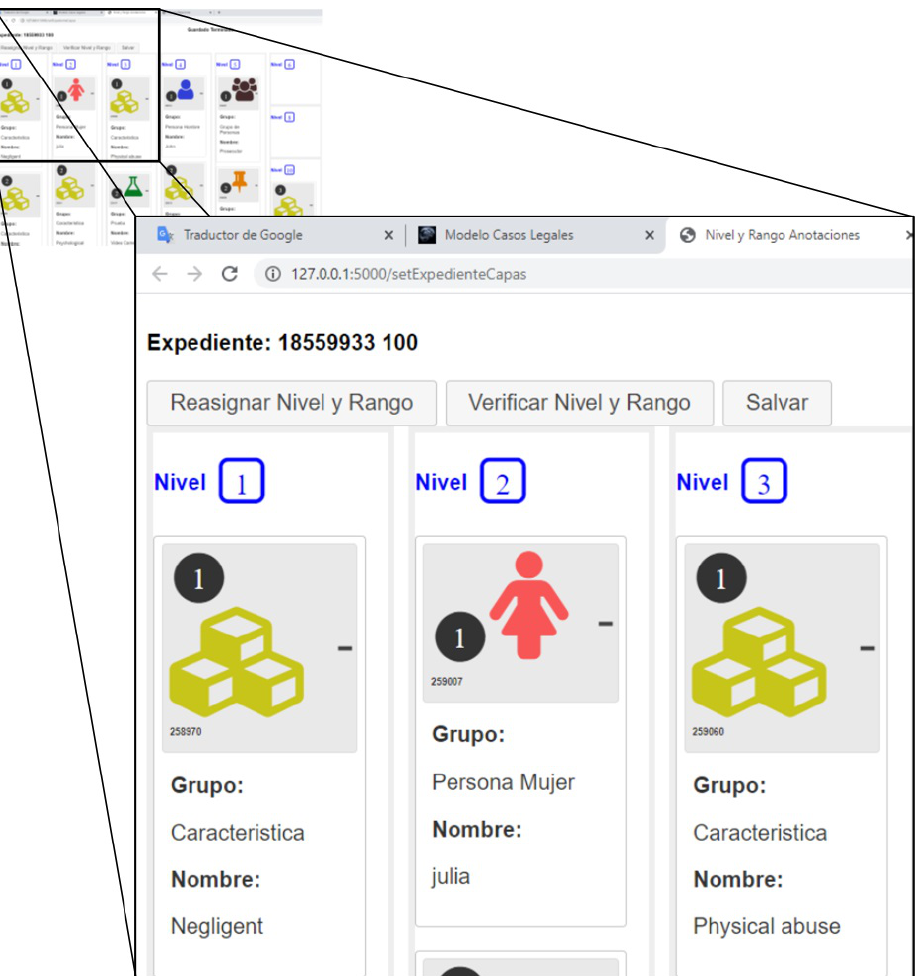
Figure 5. Judges use EGI to classify the granules of information in a case according to their perspective. The levels represent the degree of interest (importance), and the location of each granule within each level represents the order of precedence (range). Again, the granules can represent facts or evidence, as well as other case